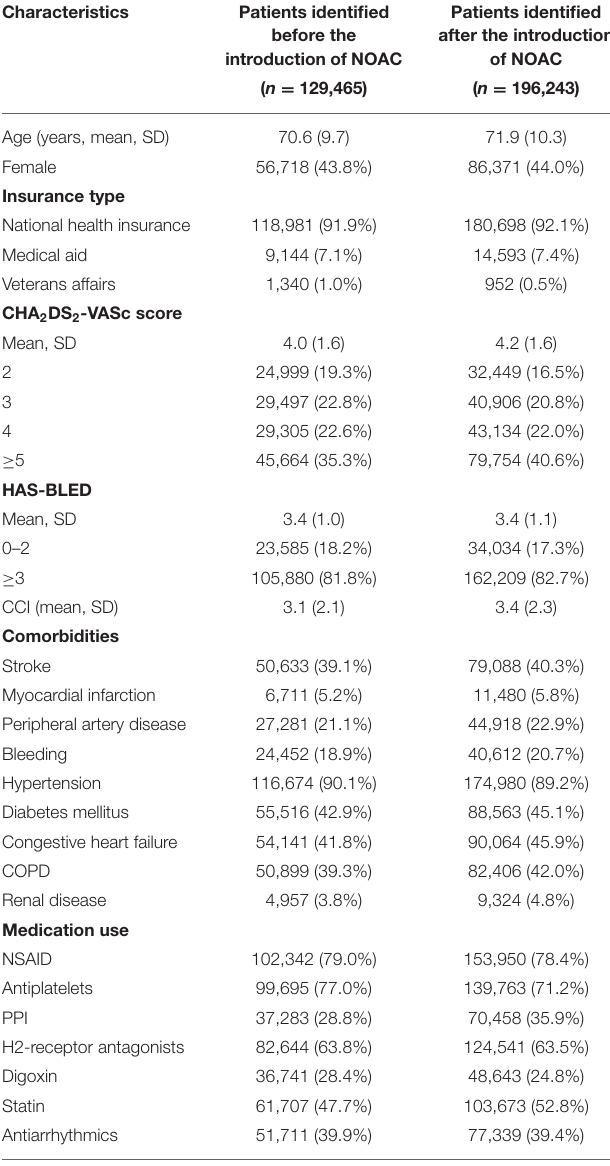
TABLE 1 | Baseline characteristics of study